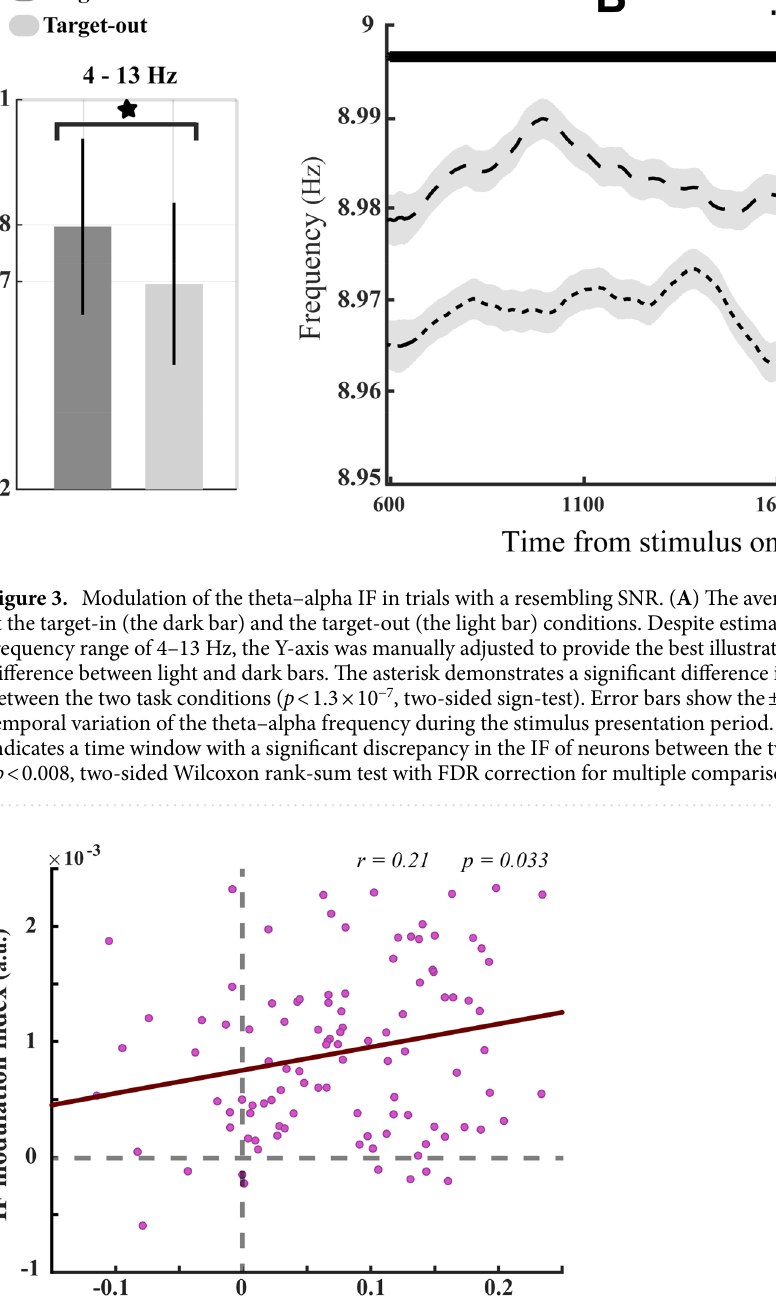
Correlation between spike‑phase coupling (SPC) and the neural IF. SPC represents oscillatory phase synchrony between the LFP and the single-unit spiking activity, recorded simultaneously from a single electrode. To esti- mate the SPC in the fast and the slow RT trials of the target-in condition, we employed the WHWT to filter the LFPs in a high-gamma frequency range of 190 to 210 Hz, with a step of 2 Hz and a bandwidth of 2 Hz. The frequency range of 190–210 Hz was chosen based on a recent study, indicating the maximum SPC differences in that frequency band between the fast and the slow RT trials 6 . Next, the instantaneous phase (IP) of filtered